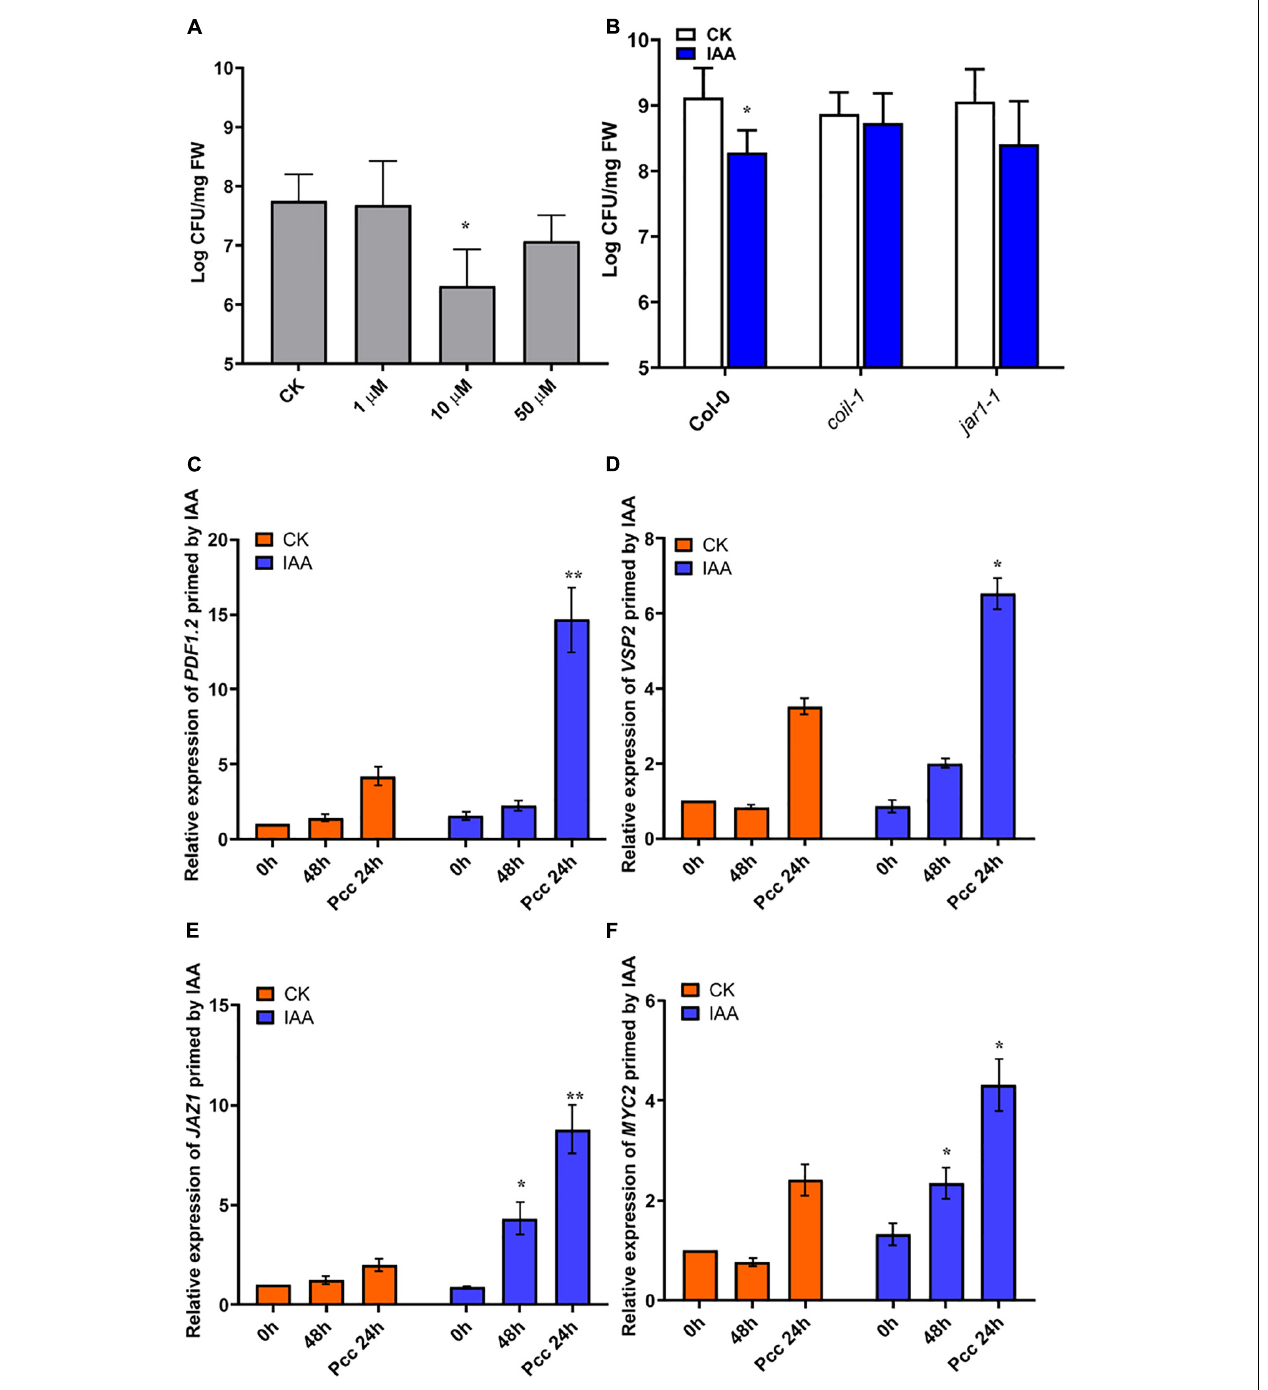
FIGURE 7 | IAA induces resistance to Pcc in a JA-dependent manner. (A) Effects of different concentrations of IAA on the proliferation of Pcc in the leaves of Arabidopsis plants (grown in a hydroponic system). (B) Proliferation of Pcc in the leaves of Col-0 , coi1-1 , jar1-1 (grown in a hydroponic system) in which the roots were pretreated with 10 µ M IAA for 48 h and the leaves were subsequently spray-inoculated with 10 7 CFU/mL Pcc . (C–F) Expressions of JAZ1 , MYC2 , PDF1.2, and VSP2 induced by 10 µ M IAA. At least five independent experiments were performed, each of which with three technical repeats. Asterisks indicate a statistically significant difference between the AHL-pretreated and the water-treated plants ANOVA test, (* P < 0.05, ** P < 0.01). Values are means ± SD of five independent experiments.